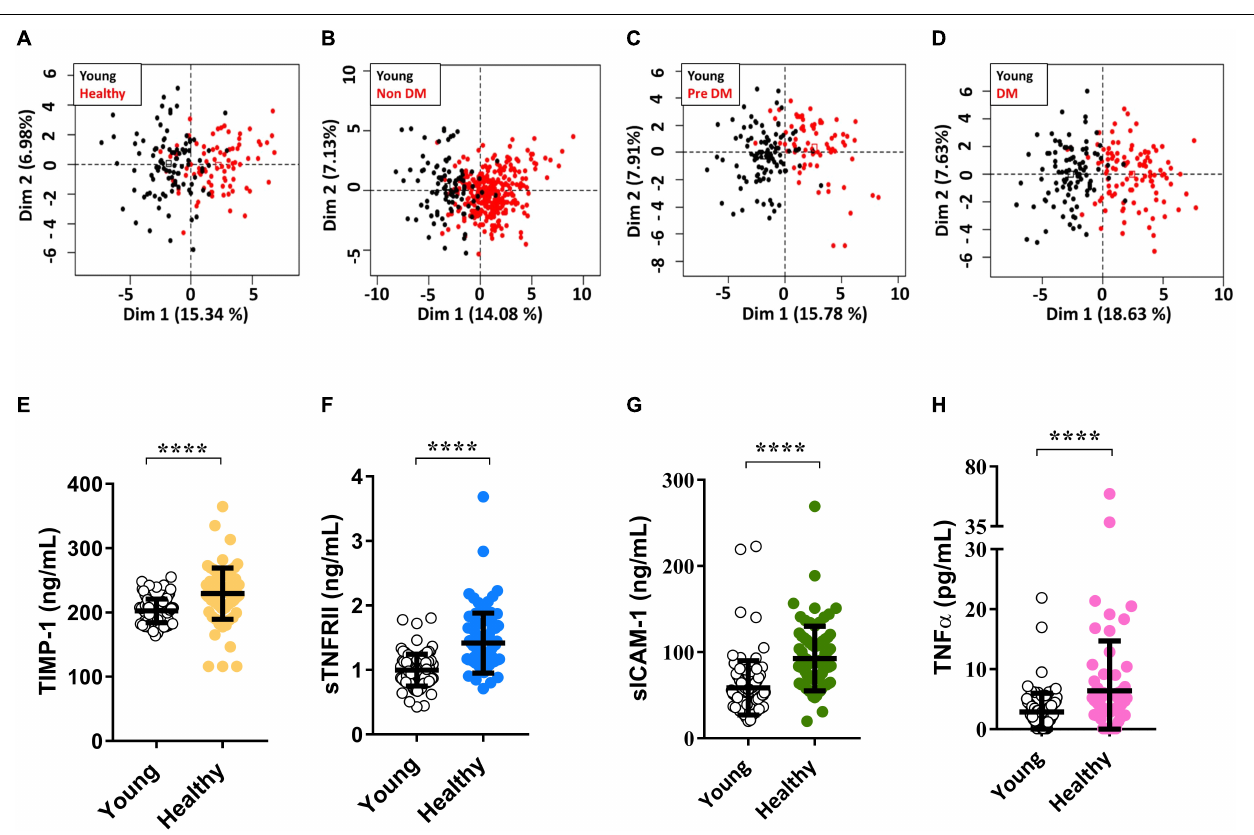
FIGURE 2 | Higher level of the inflammatory molecules with aging. Unbiased analysis of all measured cytokines and chemokines using Principal Component Analysis (PCA) shows a clear separation between Young vs. Healthy (A) , Young vs. Non-DM (B) , Young vs. Pre DM (C) , and Young vs. DM (D) . Individual comparison of major cytokines shows a significant difference ( P < 0.05) between Young vs. healthy for TIMP-1 (E) , sTNFRII (F) , sICAM-1 (G) , and TNF α (H) . P -values were calculated using non-parametric Mann–Whitney U -test and adjusted for Bonferroni multiple test correction ( ∗∗∗∗ P <